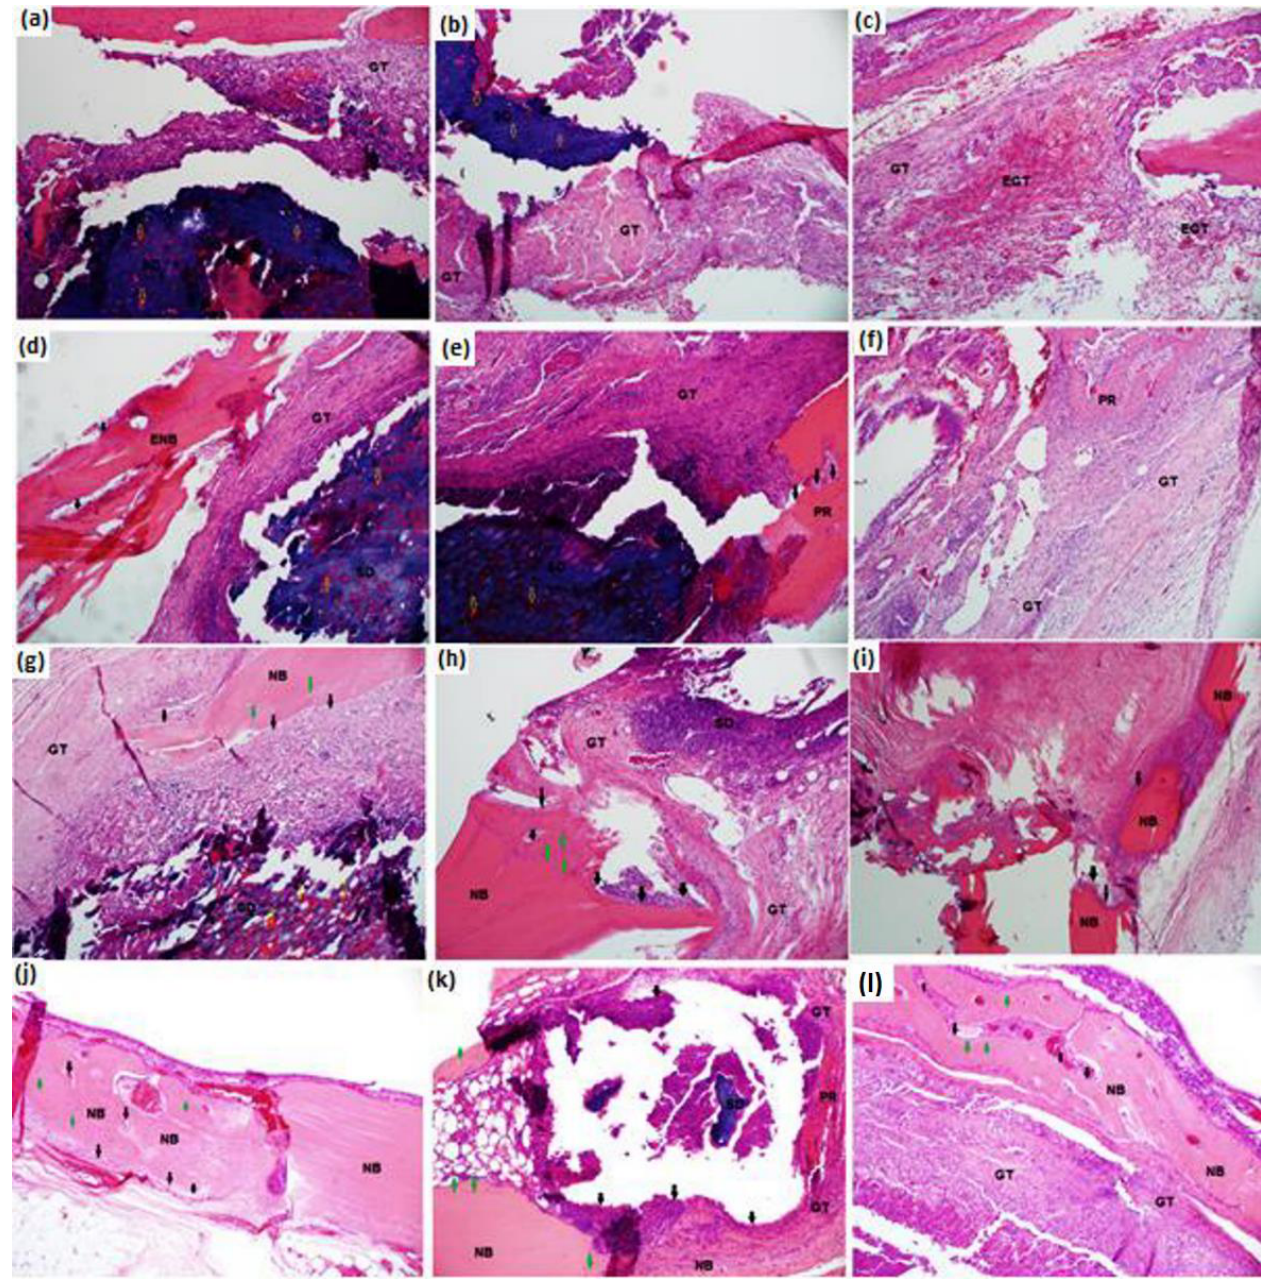
Figure 7. Histological images of ( a ) scaffold with BMP-7, ( b ) scaffold without BMP-7, ( c ) an empty nasal defect at week one postoperative and histological images of ( d ) scaffold with BMP-7, ( e ) scaffold without BMP-7, ( f ) an empty nasal defect at week two postoperative, and histological images of ( g ) scaffold with BMP-7, ( h ) scaffold without BMP-7, ( i ) an empty nasal defect at week 4 postoperative and histological images of the ( j ) scaffold with BMP-7, ( k ) scaffold without BMP-7, ( l ) an empty nasal defect at week 8 postoperative, with H&E staining (×10 magnification): GT = granulation tissue; SD = scaffold mostly represented by the space; yellow arrows = blood vessels within the scaffold, ENB = early new bone development, Black arrows = osteoblast, PR = periosteal reactions, NB = new bone development, Green arrows = osteocytes, Green star = bony spicules.